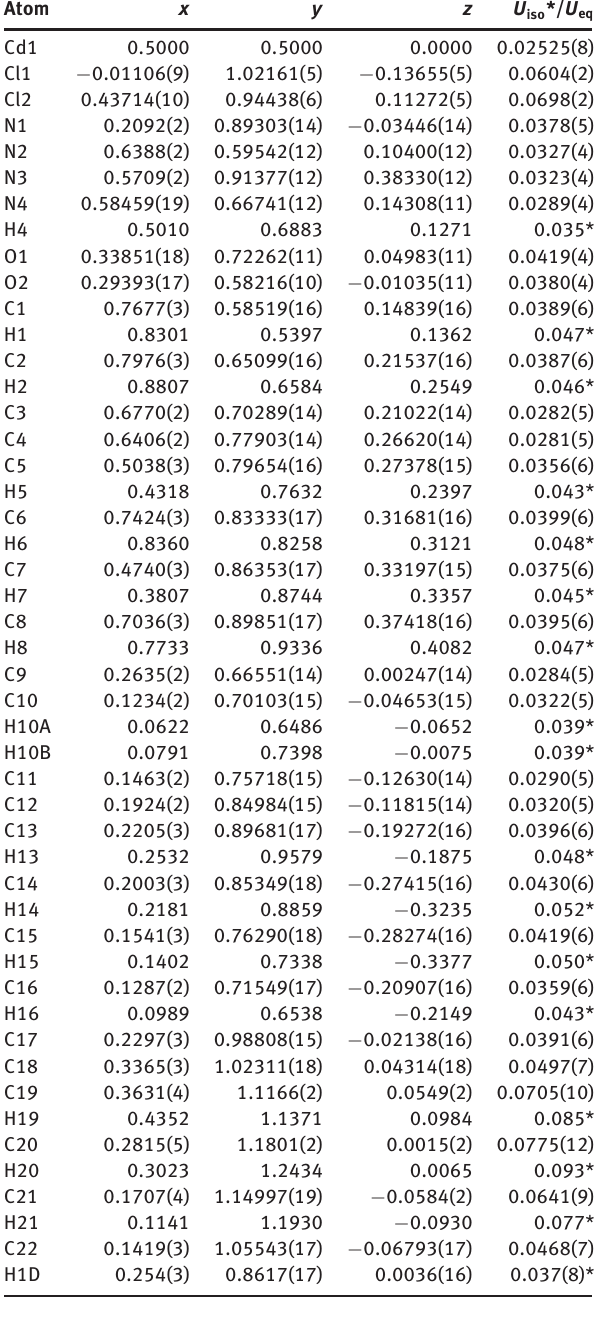
Table 2: Fractional atomic coordinates and isotropic or equivalent isotropic displacement parameters (Å 2